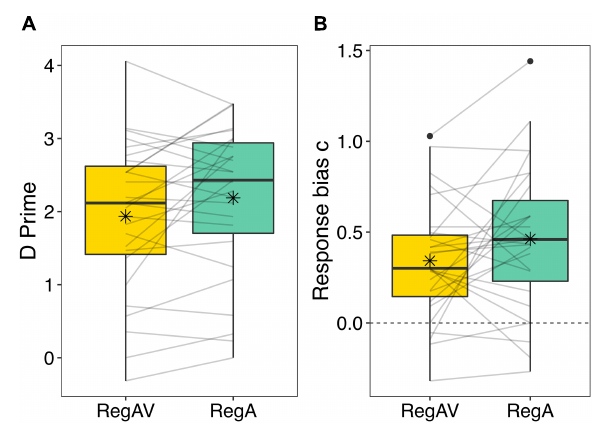
FIGURE 2 | D prime (A) and response bias c (B ) values after regular audio-visual (RegAV) primes and regular auditory (RegA) primes. Individual lines represent individual participant data, and means are represented with a black asterisk. The dotted line for response bias c refers to the point of no bias. Boxplots represent the distribution of data as implemented in ggplot2 in R (R Core Team, 2018), with the black line representing the median, the box representing the interquartile range, the whiskers presenting the spread of data, and extra points representing potential